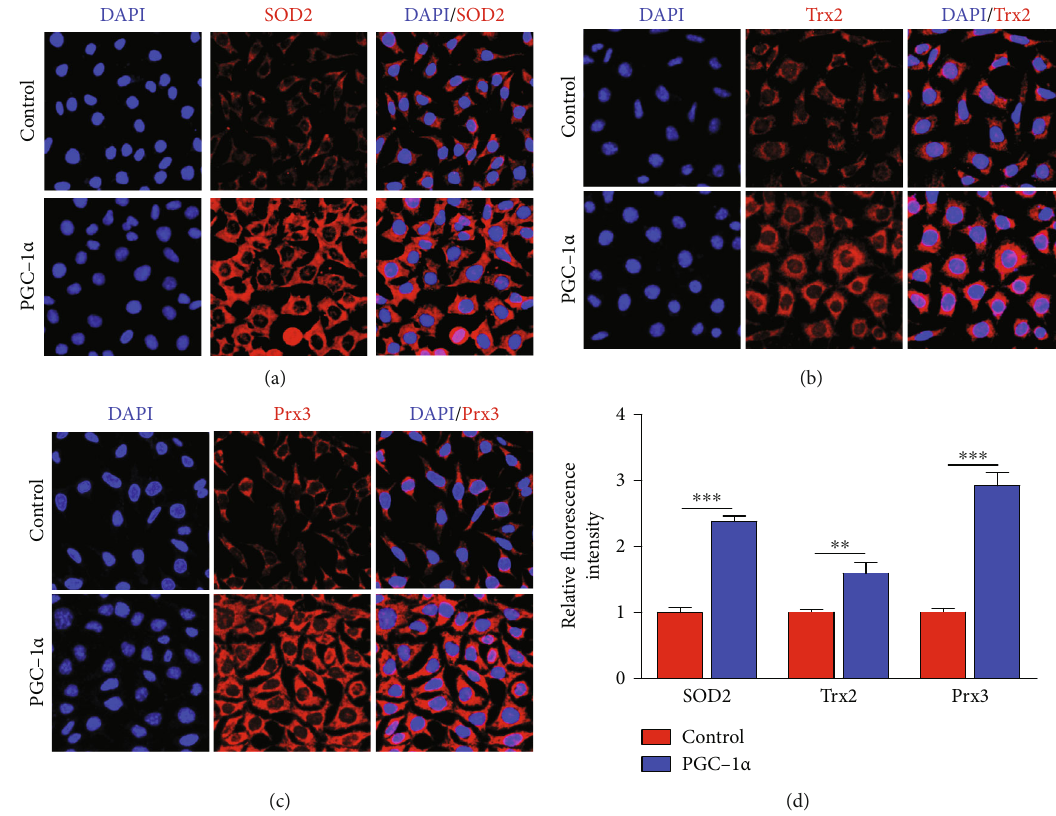
Figure 6: PGC-1 α promotes the expression of mitochondrial antioxidants in hippocampal cells. (a) Representative images of SOD2 expression in HT-22 cells with or without PGC-1 α overexpression after OGD treatment. (b) Representative images of Trx2 expression in HT-22 cells with or without PGC-1 α overexpression after OGD treatment. (c) Representative images of Prx3 expression in HT-22 cells with or without PGC-1 α overexpression after OGD treatment. (d) Quanti fi cation of the relative fl uorescence intensity of SOD2, Trx2, and Prx3 using ImageJ software. ∗∗ p < 0 : 01, ∗∗∗ p < 0 : 001 ; n = 8 per